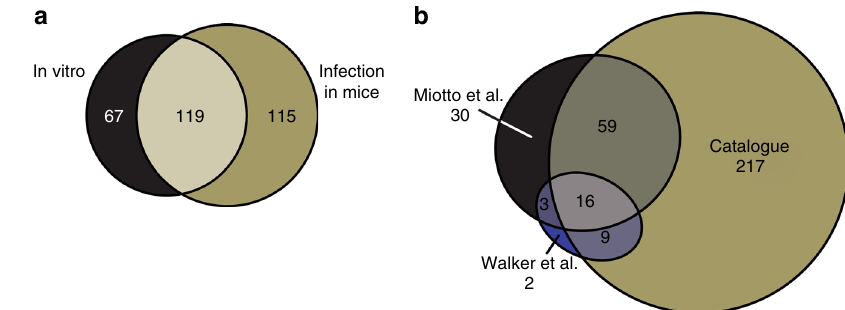
Fig. 3 Catalog of resistant amino acid substitutions after pyrazinamide treatment in vitro and during infection in mice. a Comparison of enriched non-synonymous amino acid substitutions identi fi ed after pyrazinamide treatment in vitro and during infection in mice. b Comparison of pyrazinamide resistant non-synonymous amino acid substitutions from this study (Catalog) and from clinical isolates (Miotto et al. 32 and Walker et al. 47